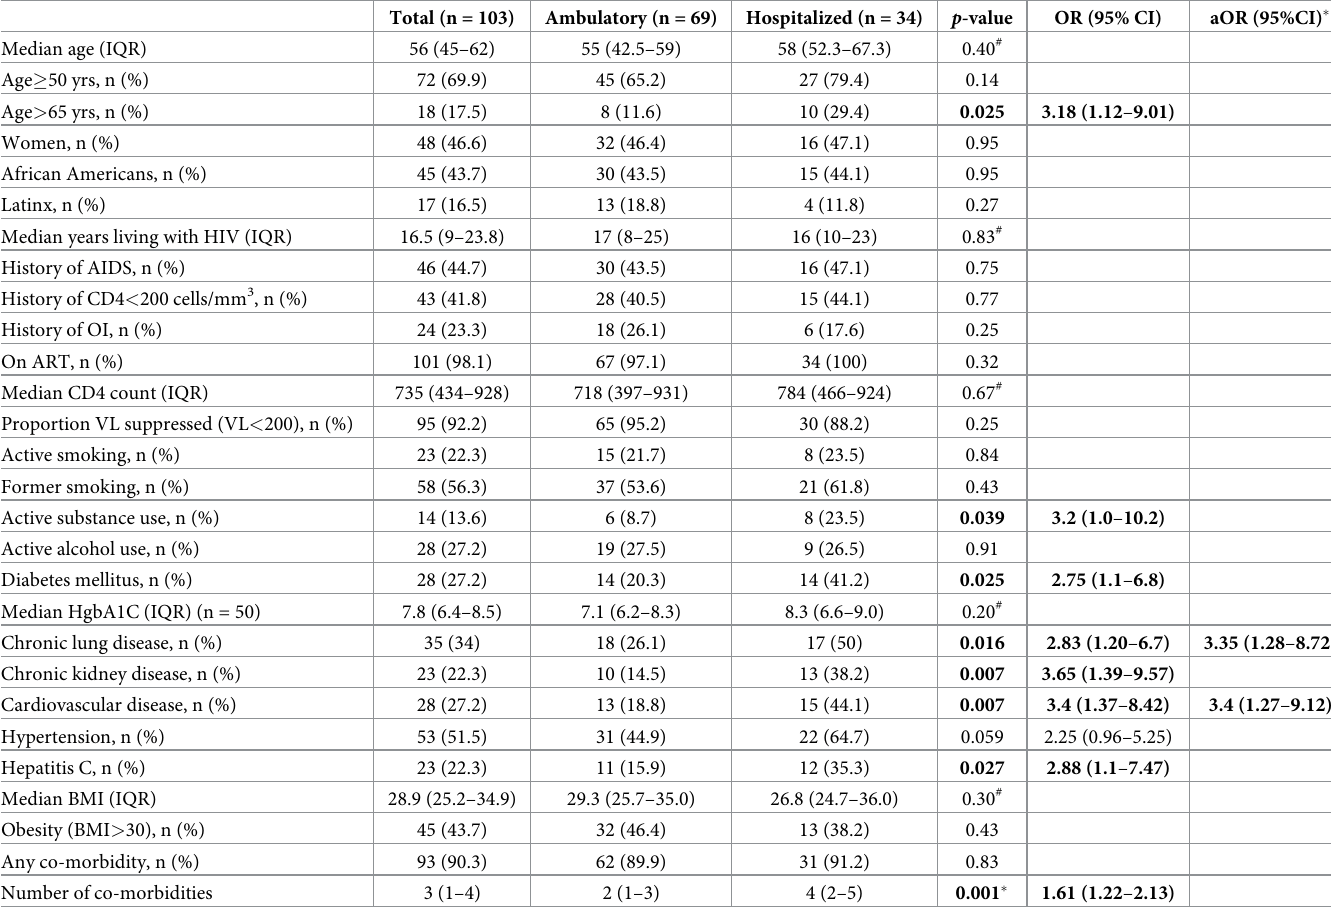
Table 1. Demographics and clinical characteristics of a cohort of PWH and COVID-19 by hospitalization status: